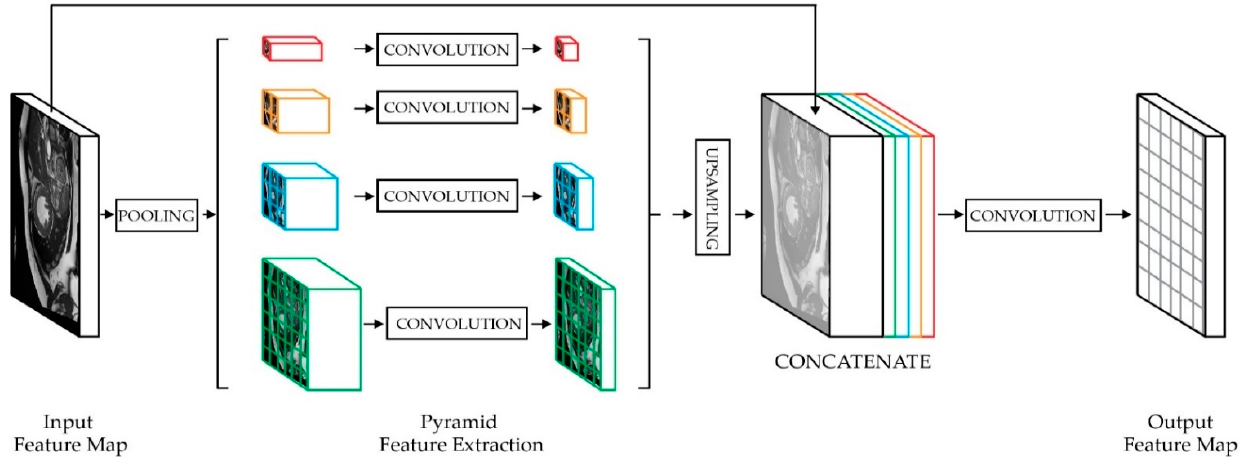
Figure 4. The spatial-pyramid-pooling module extracts information from different scales that varies among different subregions. Using a four-level pyramid, the pooling kernels cover the whole, half, and small portions of the image. A more powerful representation could be fused with information from the different subregions within these receptive fields.